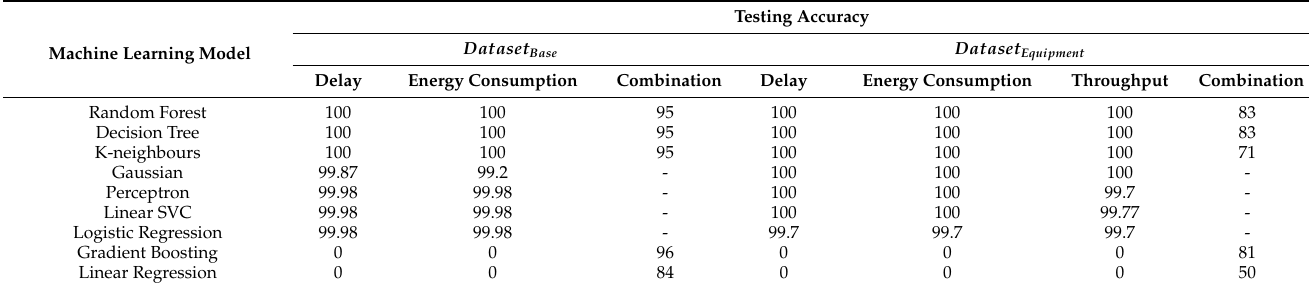
Table 4. Accuracy of machine learning models for single and combined performance metrics prediction with respect to Dataset Base and Dataset Equipment